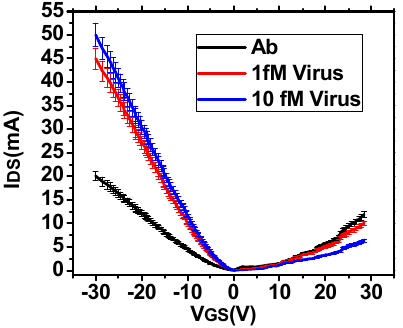
Figure 4. Variation of I DS with V GS after antibody binding and with increasing concentration of Hep-B virus. The sensitivity has been computed as the maximum fractional change in I DS after Hep-B capture. It is observed from Figure 4, that the sensitivity is maximum corresponding to a V GS of − 30 V. Thus,